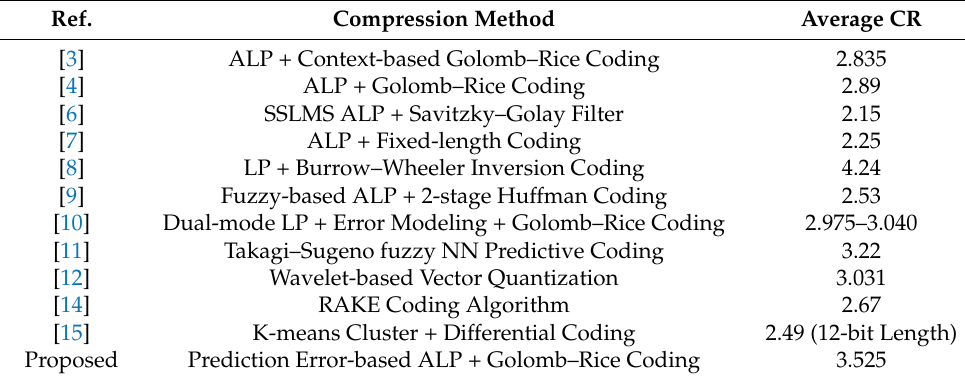
Table 3. The comparison of the average compression ratio to other methods on MITDB data set.